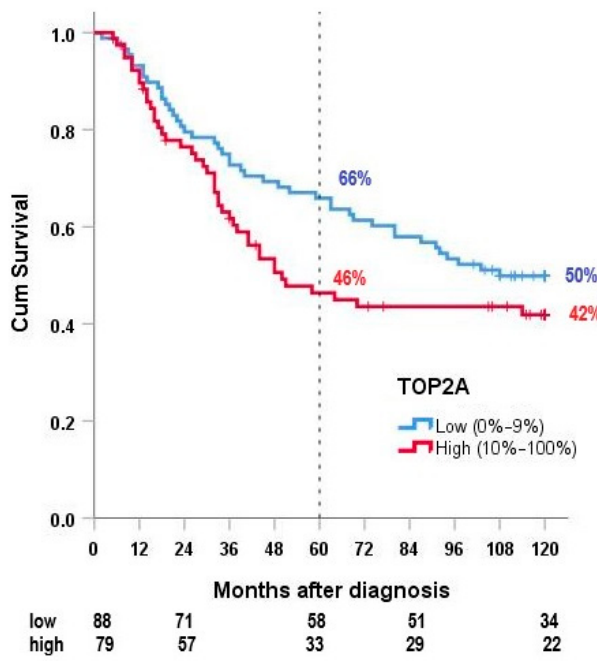
Figure 3. Overall survival according to TOP2A expression.